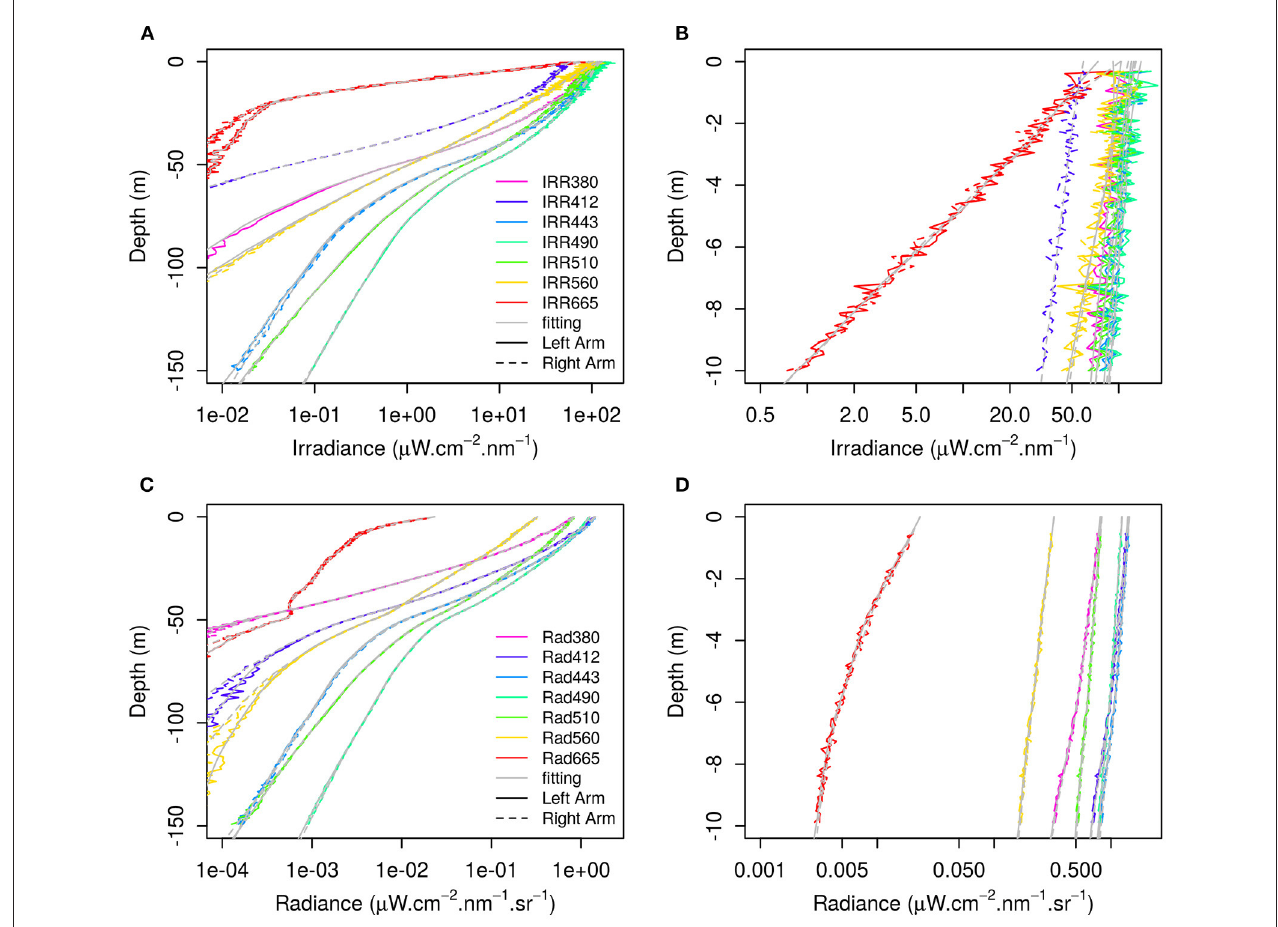
local maximum of radiance at 665nm at the same depth. Data from left arm (solid lines) and from right arm (dashed lines) are as expected mostly superimposed except at depth where dark correction issues